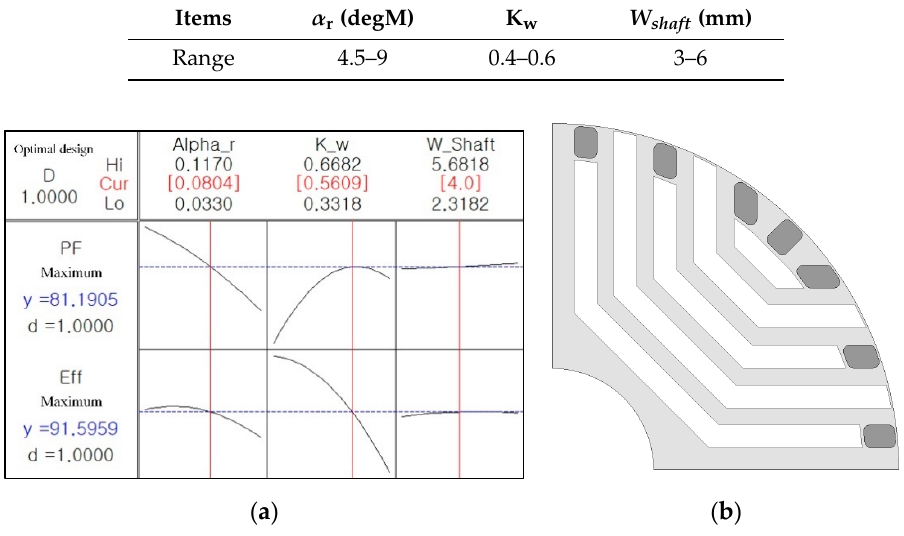
Figure 7. Design parameters for the optimal design using the response surface method (RSM).